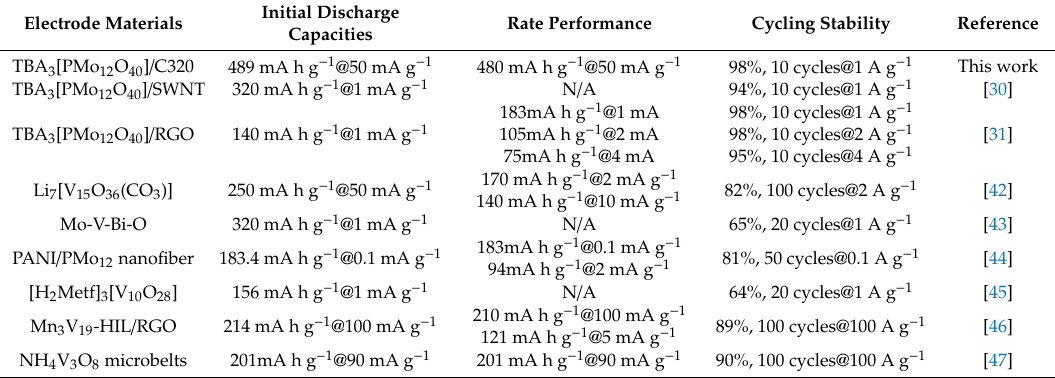
Table 2. Electrochemical performances of POM-based electrode materials used in lithium ion batteries.